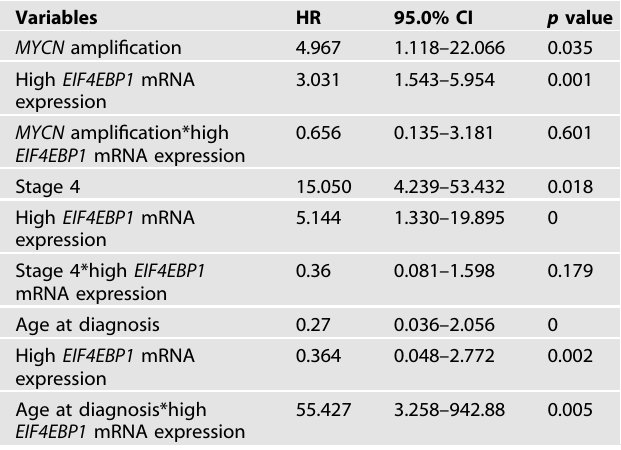
EIF4EBP1 expression is a factor of poor prognosis in NB